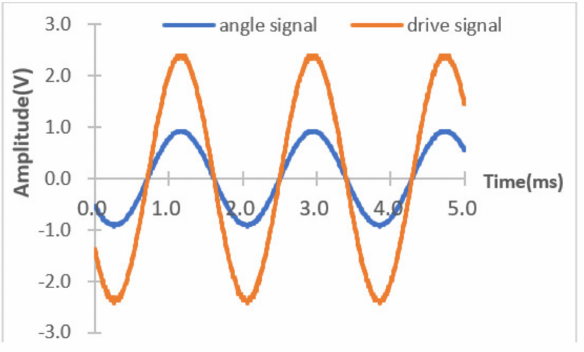
Figure 21. The relationship between scanning angle and wavelength range of the detectors. The experimental system was set up to test the performance of the system circuit and spectrometer. The output signal of the angle sensor and the original spectrum signal were sampled using an oscilloscope. The square wave driving signal was used to drive the MOEMS integrated scanning grating micro-mirror motion, as shown in Figure 22. At this point, the angle output of the original signal was about 2.5 mV in size, and the amplified signal was approximately 980 mV and the scanning angle was about 6.2 degrees.